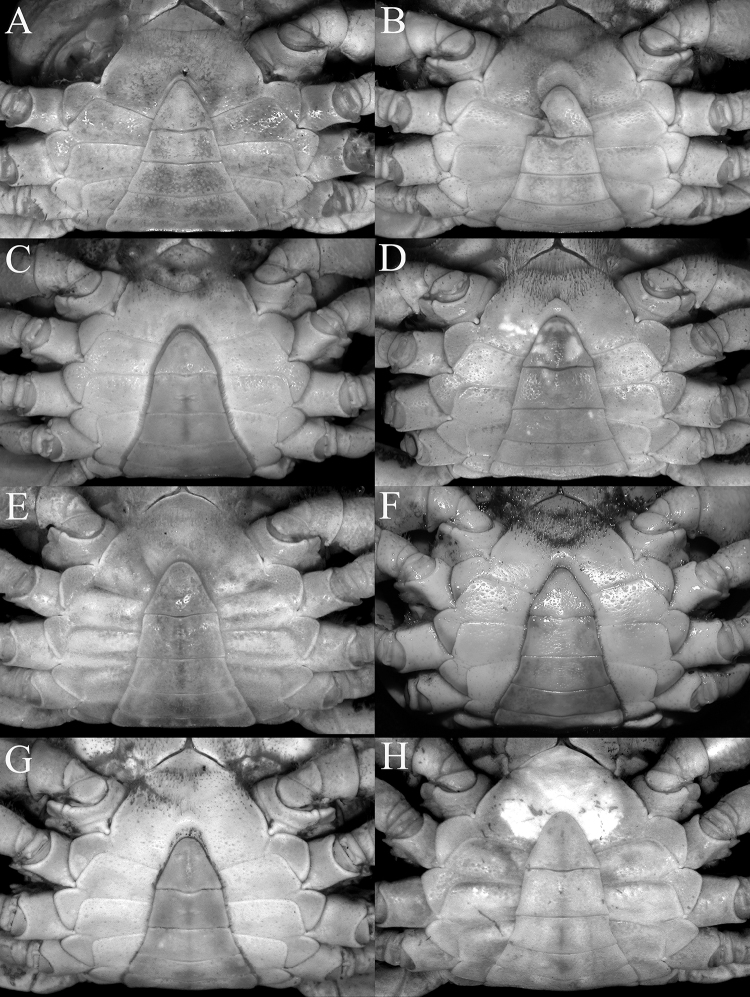
Anterior thoracic sternum and pleon AJohora
intermedia Ng, 1986, holotype male (19.8 × 15.1 mm) (ZRC 1984.6529), Pahang BJ.
tahanensis (Bott, 1966), male (30.7 × 25.5 mm) (ZRC 1984.6795), Pahang CJ.
thoi Ng, 1990, holotype male (41.2 × 33.3 mm) (ZRC 1989.2249), Terengganu DJ.
hoiseni Ng & Takeda, 1992, holotype male (25.1 × 21.1 mm) (ZRC 1984.6673), Kelantan EJ.
thaiana Leelawathanagoon, Lheknim & Ng, 2005, paratype male (22.2 × 18.6 mm) (ZRC 2006.0052), Thailand FJ.
booliati sp. nov., holotype male (34.6 × 30.0 mm) (ZRC 2020.0072), Pahang GJ.
erici sp. nov., holotype male (38.3 × 32.0 mm) (ZRC 2020.0360), Perak HJ.
michaeli sp. nov., holotype male (22.7 × 19.2 mm) (ZRC 2010.0047), Terengganu.